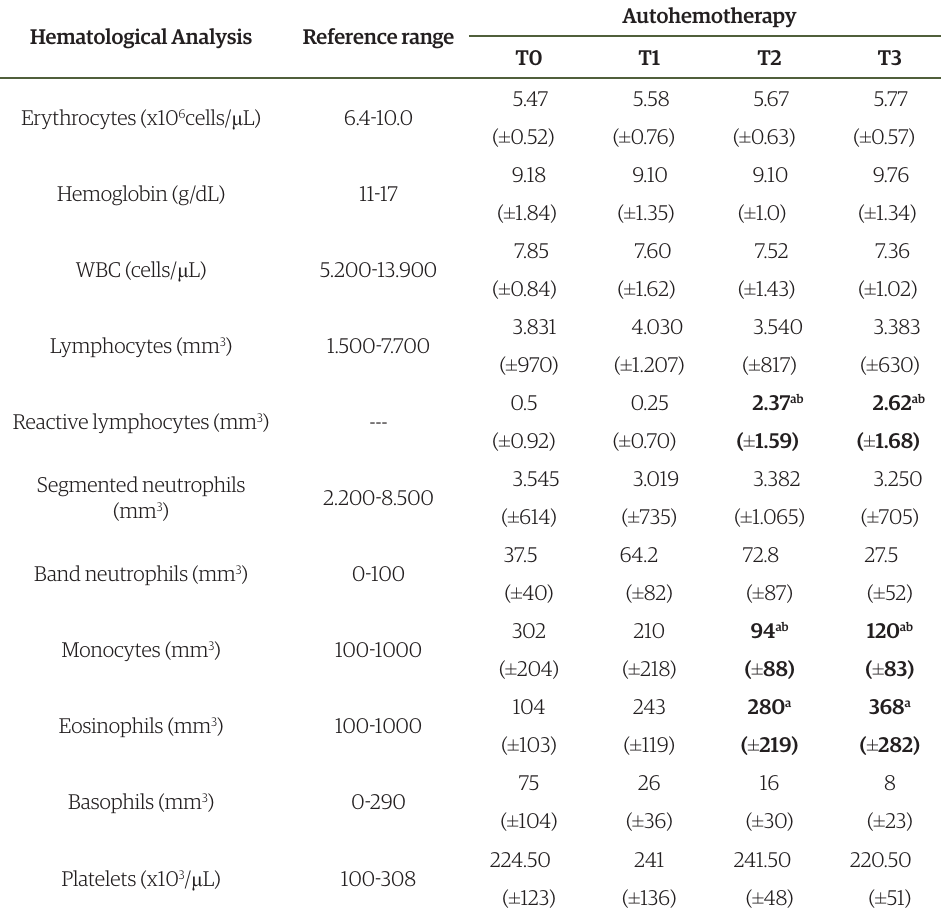
Table 3. Hematological blood tests and reference ranges in horses submitted to autohemotherapy over time.